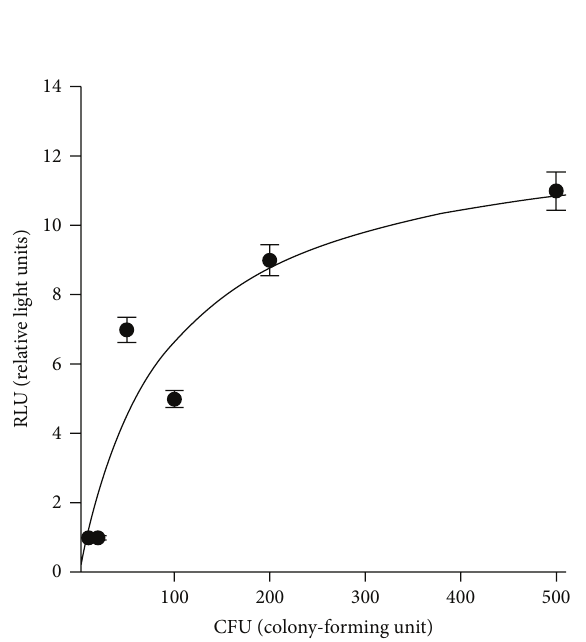
Figure 1: Linear relationship graph.